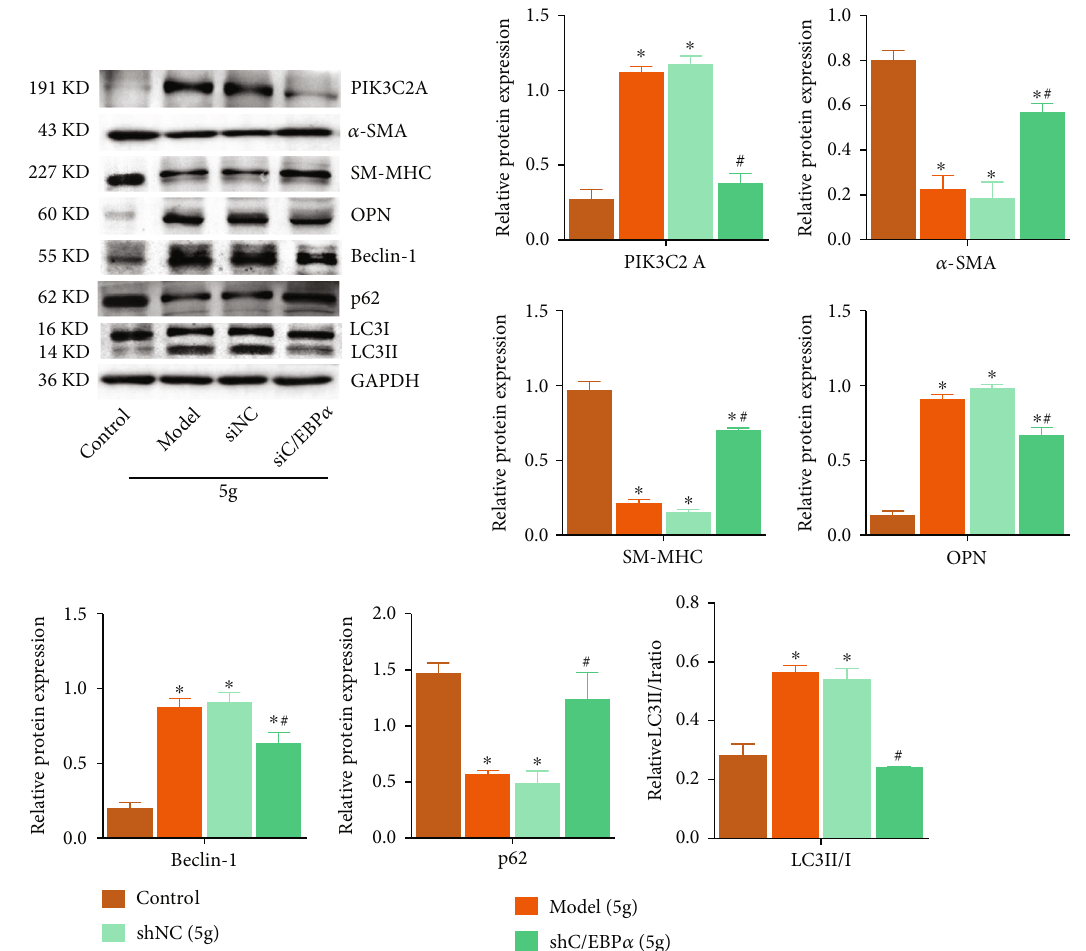
Figure 11: The impact of C/EBP α de fi ciency in stretch-activated aortic rings of AD rat. C/EBP α expression in vivo was knocked down using C/EBP α shRNA lentivirus in AD rats, and the aortic rings were collected, stretched by 5 g for 30 minutes, and analyzed the protein levels of PIK3C2A, α -SMA, SM-MHC, OPN, LC3, Beclin-1, and p62 by Western blot. Representative images and the quantitative relative expression were shown. ∗ P < 0 : 05 vs. control, # P < 0 : 05 vs. model (5 g).